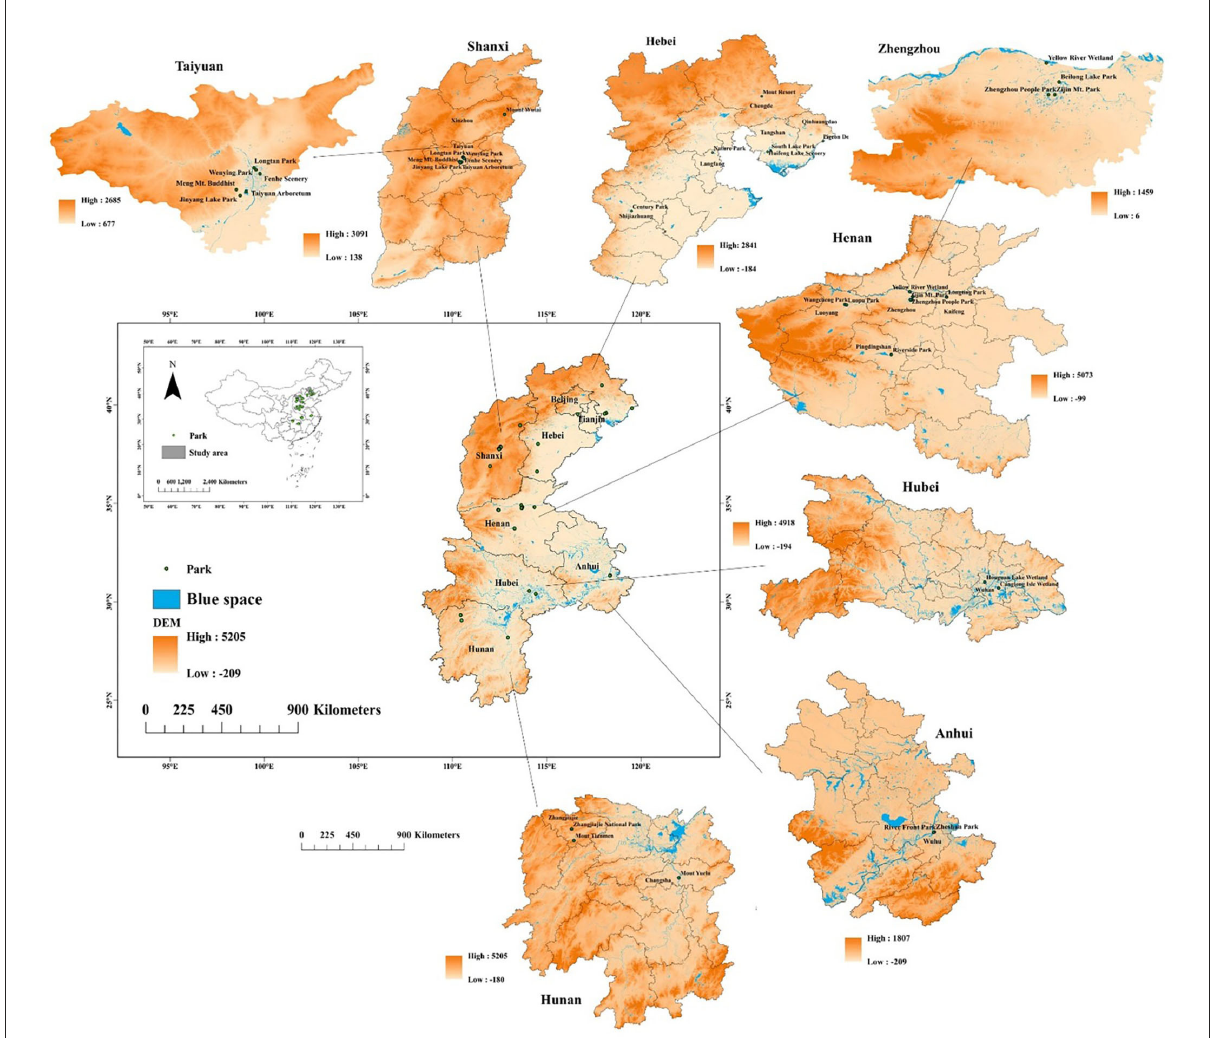
FIGURE1 Spatial distribution of urban wetland parks for data collection in cities of Central